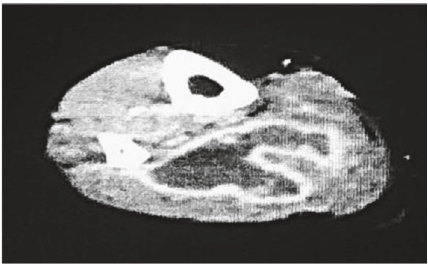
Figure 4: Contrast-enhanced CT on day 50; CT revealed a residual abscess.